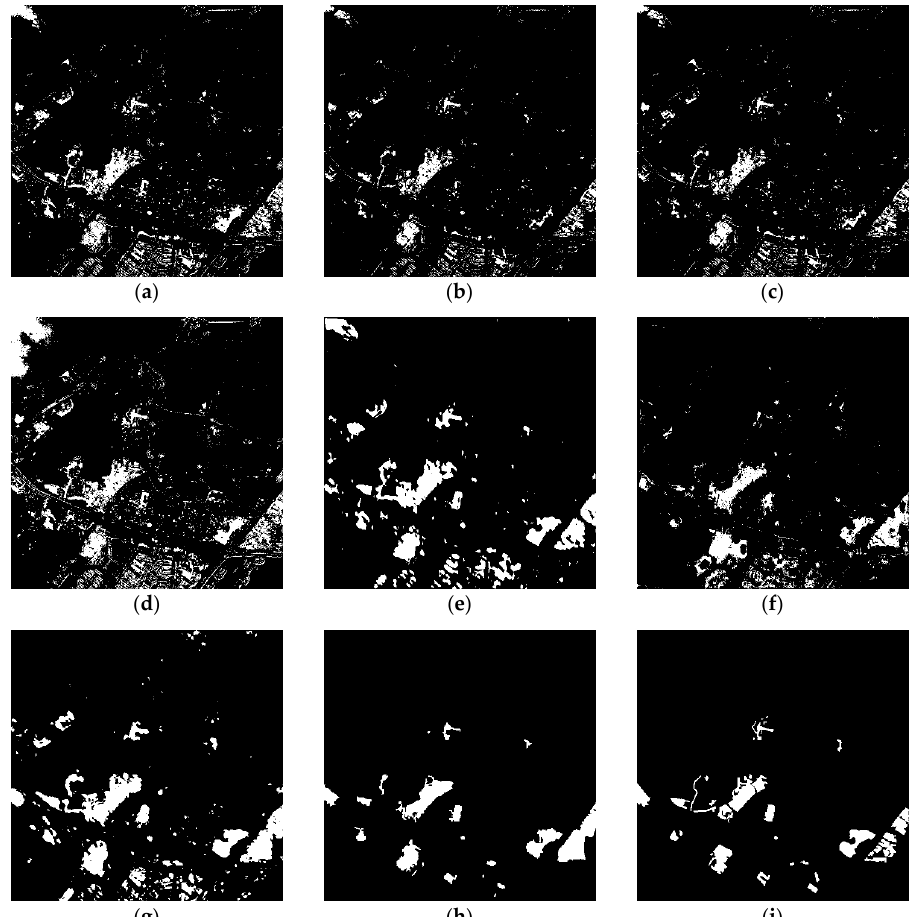
Figure 9. Change detection maps obtained on the second location by: ( a ) Extreme Learning Machine (ELM), ( b ) Support Vector Machine (SVM), ( c ) Multiple Linear Regression (MLR), ( d ) Artificial Neural Network (ANN), ( e ) Deep Convolutional Neural Network (DCNN) ( ω = 13), ( f ) Traditional Siamese Convolutional Neural Network (TSCNN) ( ω = 13), ( g ) Deep Siamese Multi-scale Convolutional Network (DSMS-CN) ( ω = 13), ( h ) Deep Siamese Convolutional Network Based on Convolutional